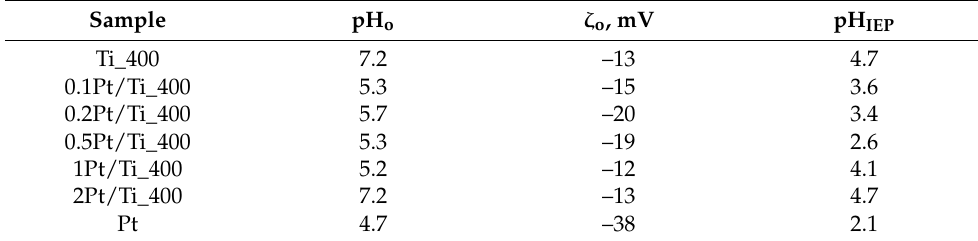
Table 2. Electrokinetic parameters of suspensions of PLAL